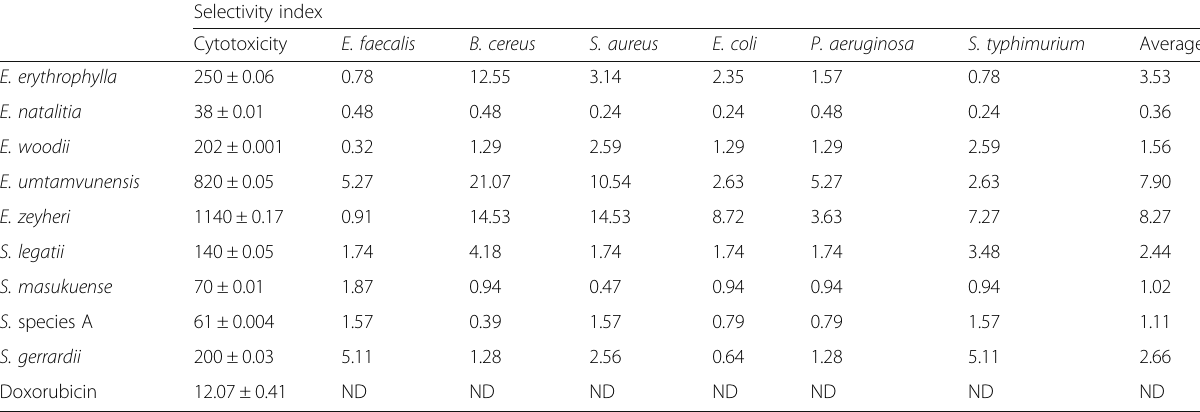
Table 3 Cytotoxicity against Vero cells LC 50 ( μ g/ml) and Selectivity index of the nine selected acetone crude extracts. Selectivity index values more than 1 are non-toxic extracts with a relatively good safe margin and promising antibacterial agents